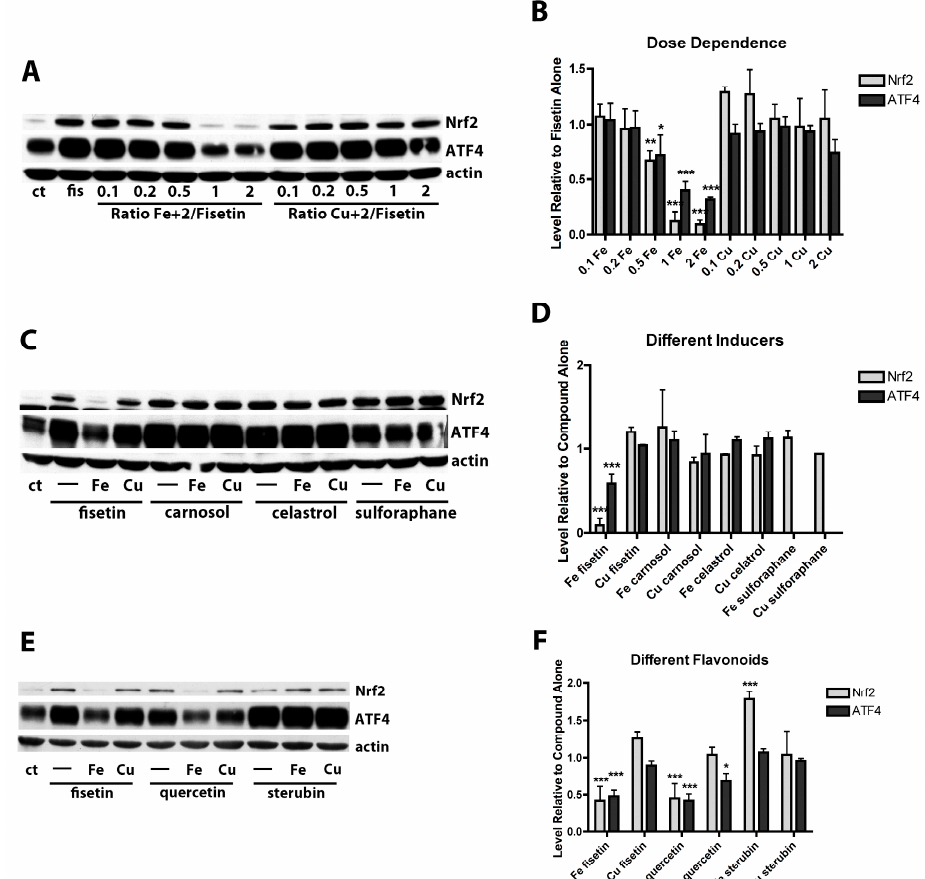
Figure 2. E ff ects of FeCl 2 and CuCl 2 on fisetin-induced increases in the transcription factors Nrf2 and ATF4. ( A ) Representative Western blots for Nrf2, ATF4 and actin of nuclear extracts from HT22 cells treated for 4 h with 5 µ M fisetin either alone (fis) or in the presence of increasing concentrations of FeCl 2 or CuCl 2 . ( B ) Quantitation of results from four independent experiments identical to ( A ). ( C ) Representative Western blots for Nrf2, ATF4 and actin of nuclear extracts from HT22 cells treated for 4 h with 5 µ M fisetin, 1 µ M carnosol, 1 µ M celastrol or 5 µ M sulforaphane either alone (-) or in the presence of a 2 fold molar excess of FeCl 2 or CuCl 2 . ( D ) Quantitation of results from three independent experiments identical to ( C ). Since sulforaphane did not induce ATF4, no results for this are shown. ( E ) Representative Western blots for Nrf2, ATF4 and actin of nuclear extracts from HT22 cells treated for 4 h with 5 µ M fisetin, 5 µ M quercetin or 5 µ M sterubin either alone (-) or in the presence of 10 µ M FeCl 2 or CuCl 2 . ( F ) Quantitation of results from four independent experiments identical to ( E ). In ( B , D ), * indicates p < 0.05, ** indicates p < 0.01 and *** indicates p < 0.001 relative to fisetin alone. In ( F ), * indicates p < 0.05 and *** indicates p < 0.001 relative to compound alone.